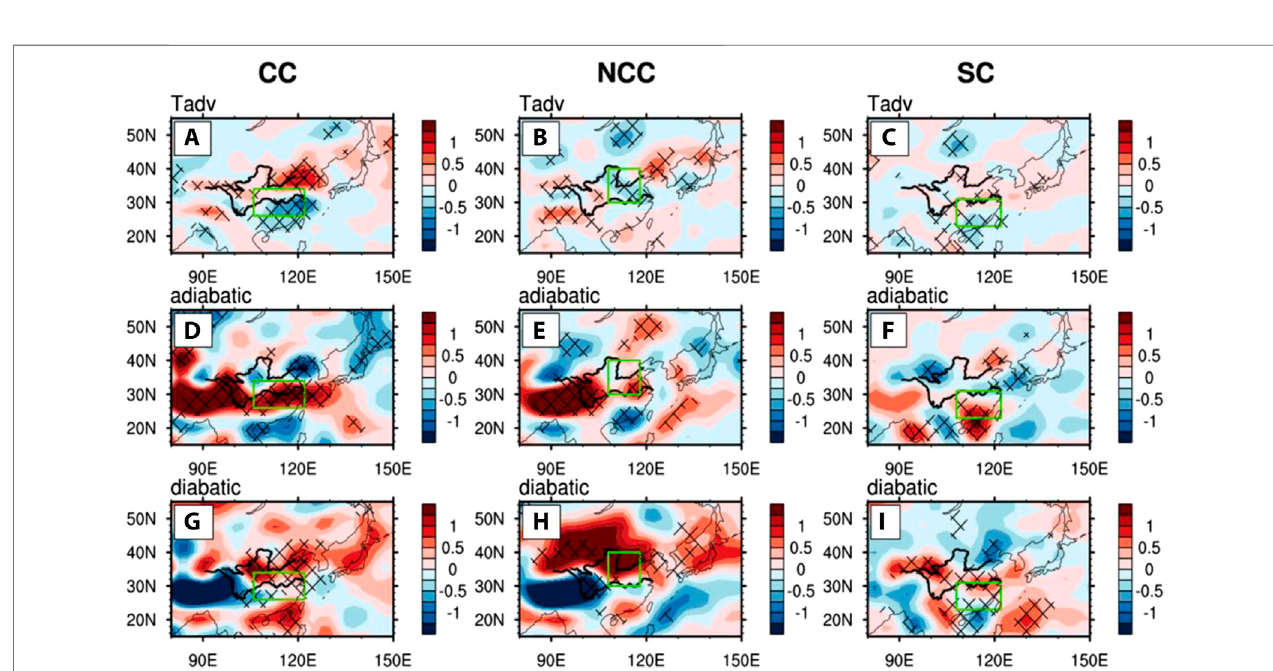
FIGURE 9 | The composite anomalies of temperature advection (A – C) , adiabatic heating (D – F), and diabatic heating (G – I) (unit: K day − 1 ) on the right hand side of thermodynamic equationin termofRPHWin CC (A, D,G) , NCC (B,E,H) , and SC (C, F,I) .Thesearedepartures from the long-term climatemean over thewhole study period. The hatched area indicates it is signi fi cant at 95% con fi dence level.